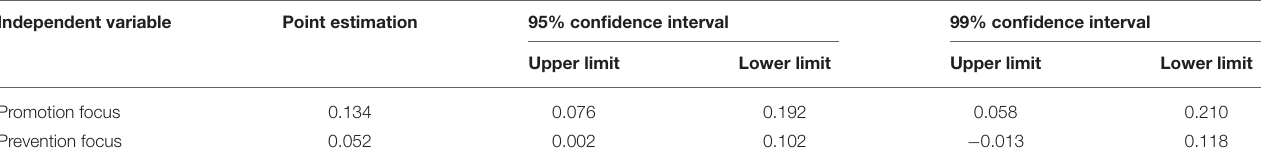
TABLE 2 | Mediating effect value of boundaryless mindset.